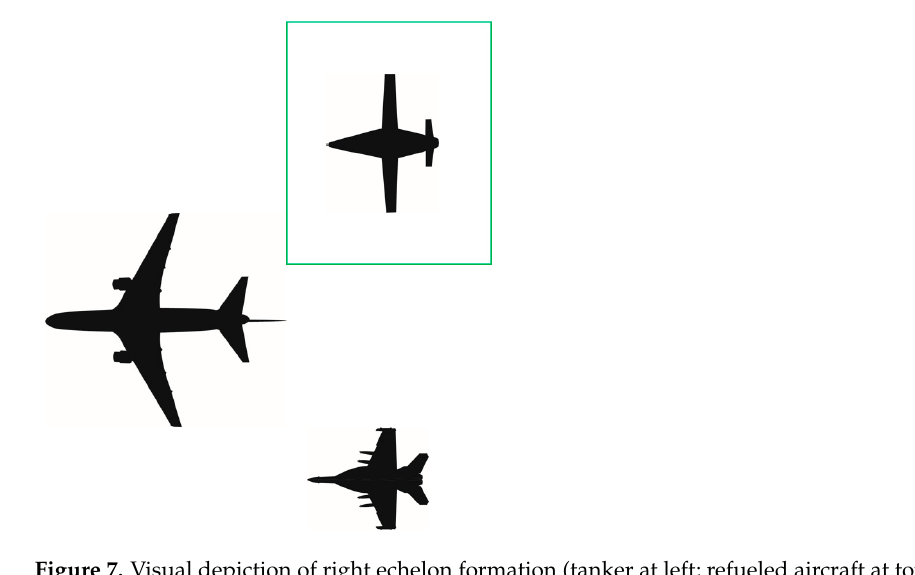
Figure 7. Visual depiction of right echelon formation (tanker at left; refueled aircraft at top right).